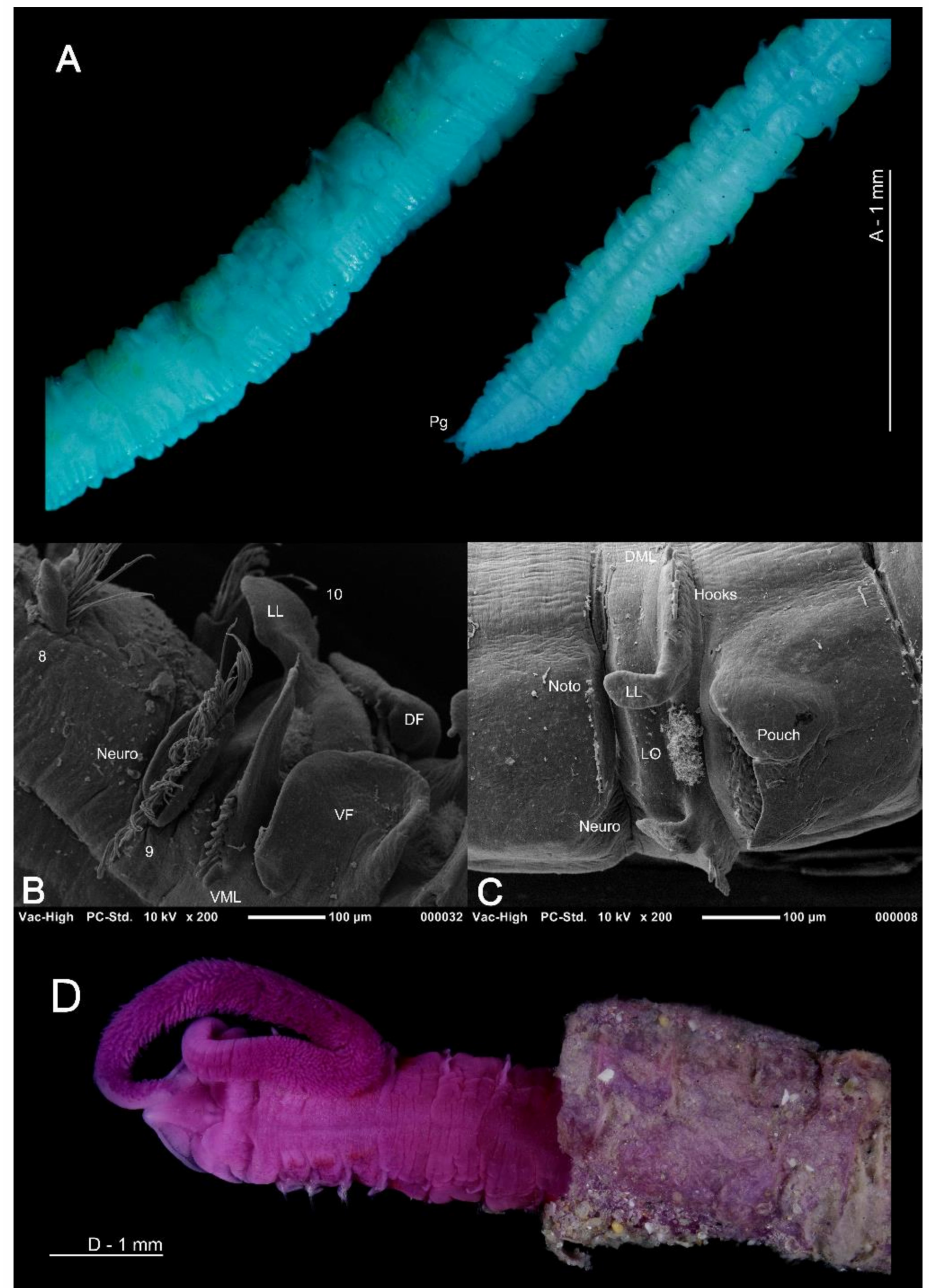
Figure 7. ( A ) Posterior abdomen and pygidium of Magelona mahensis (lateral and ventral views respectively), specimen ovigerous; ( B ) anteriorly open lateral pouch between chaetigers 10–11 of M. johnstoni (ventral view); ( C ) posteriorly open lateral pouch from posterior abdomen of M. johnstoni (lateral view); ( D ) anterior of M. alleni protruding from multi-layered sediment covered tube (dorsal view). ( A ) is stained with methyl green, ( D ) is stained with rose bengal. Abbreviations: DF—dorsal flap of the lateral pouch, DML—dorsal medial lobe, LL—lateral lamellae, LO—lateral organ, Neuro—neuropodia, Noto—notopodia, Pg—pygidium, VF—ventral flap of the lateral pouch, VML—ventral medial lobe. Numbers indicate